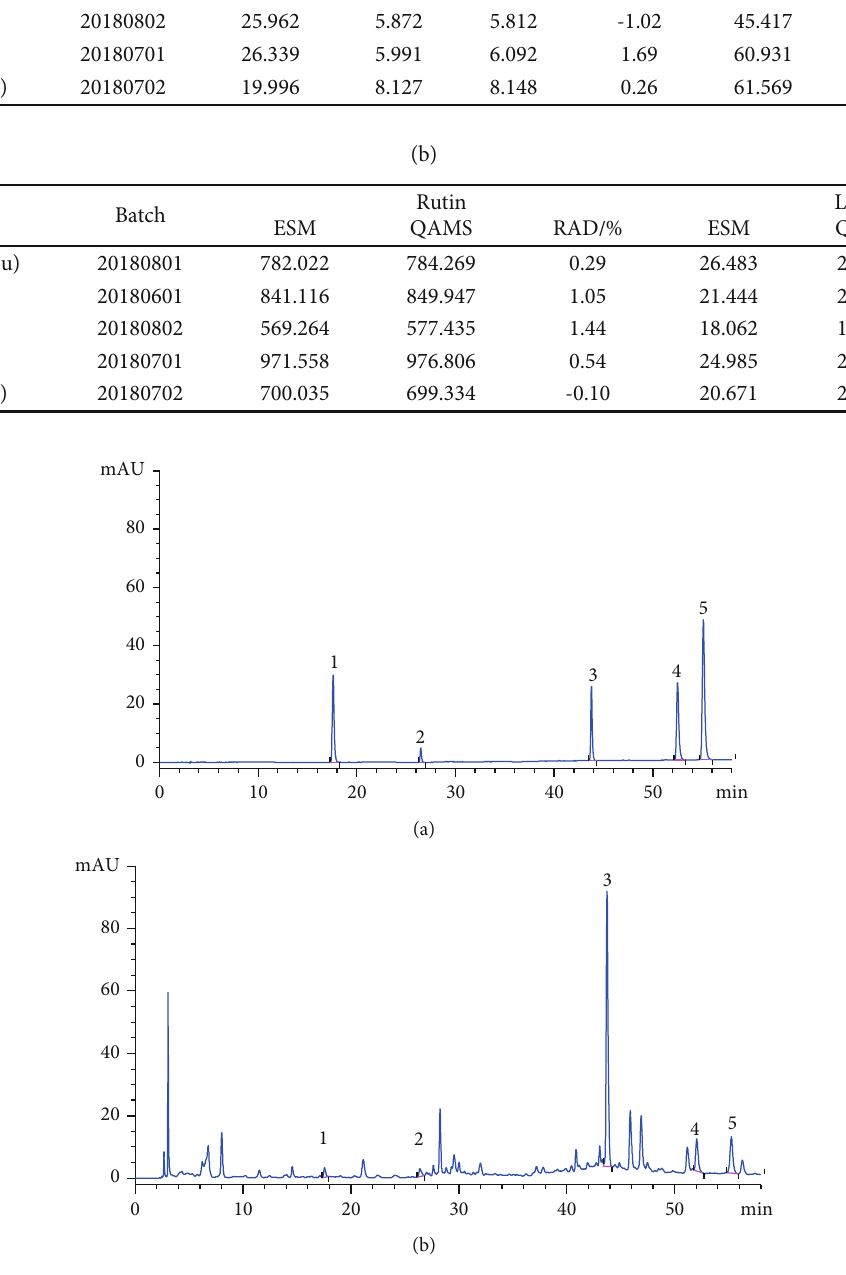
Figure 2: HPLC chromatogram (a) mixed reference substance (b) Hibiscus mutabilis L